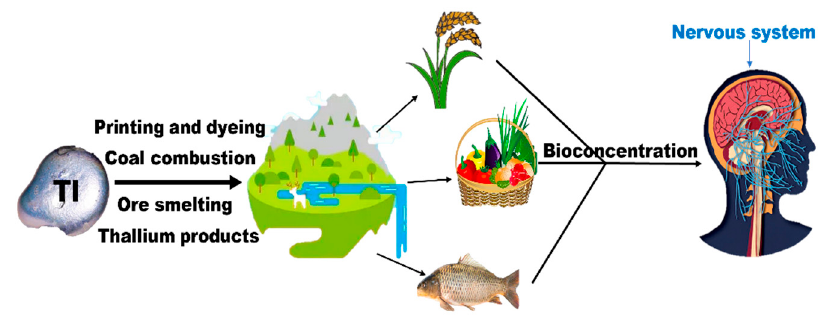
Figure 1. The effects of thallium entering the environment and the human nervous system.